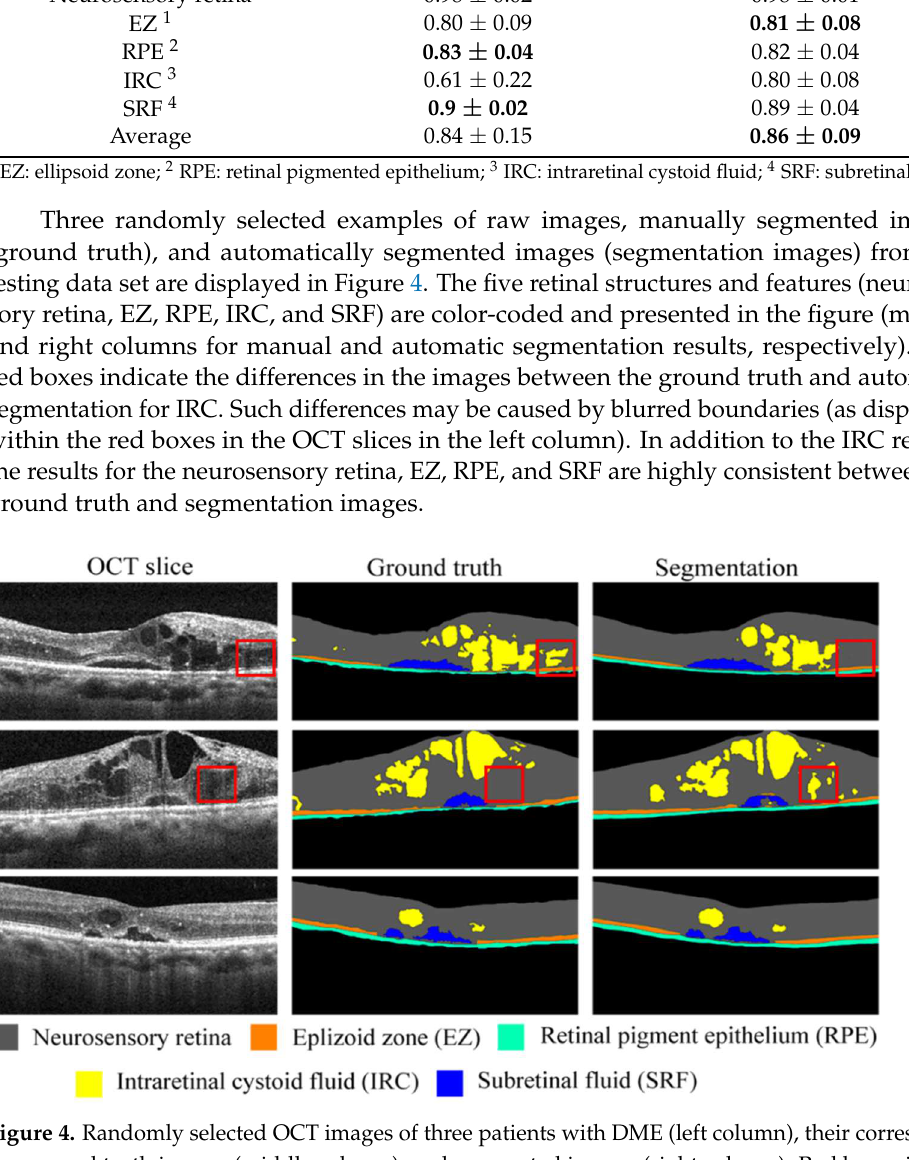
Table 3. Dice coefficient of each retinal structure and feature segmented by U-net and proposed model. The higher Dice coefficient is marked in bold. Retinal Features